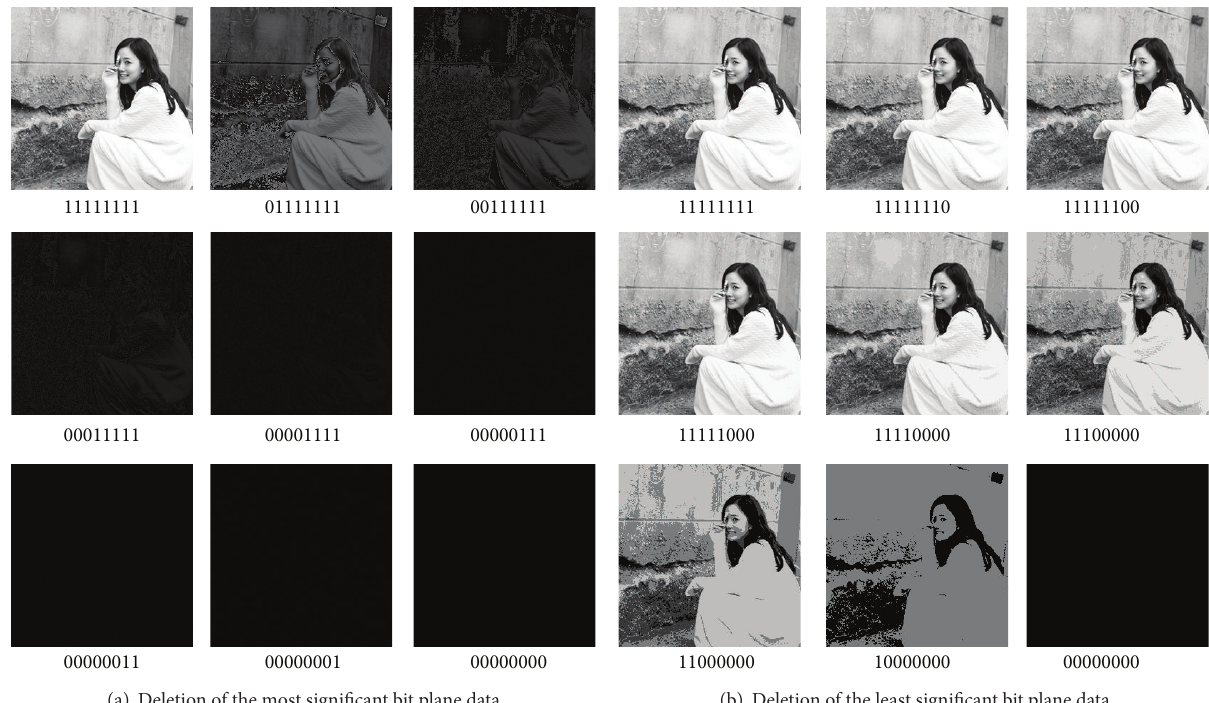
Figure 6: Changes in image quality according to the bit plane deletion.